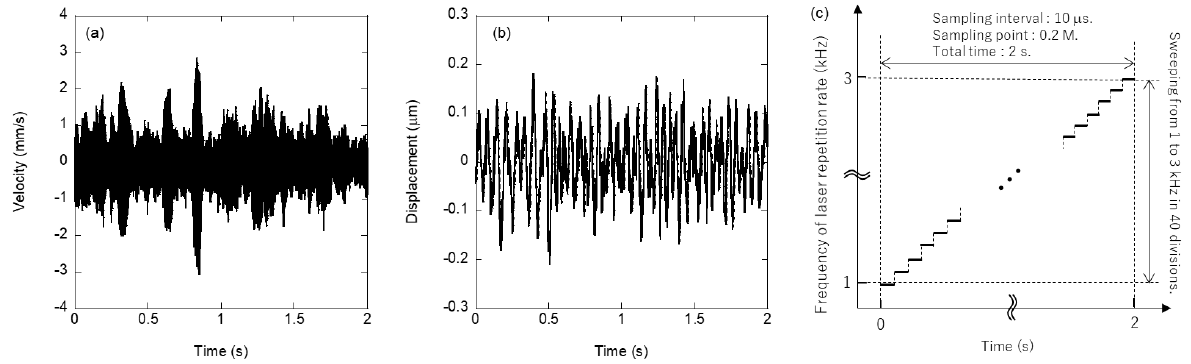
Figure 2. Time − domain vibrational signal for ( a ) the velocity and ( b ) the displacement of a copper disk sample by SPE method using ( c ) stepwise frequency sweeping. disk sample by SPE method using ( c ) stepwise frequency